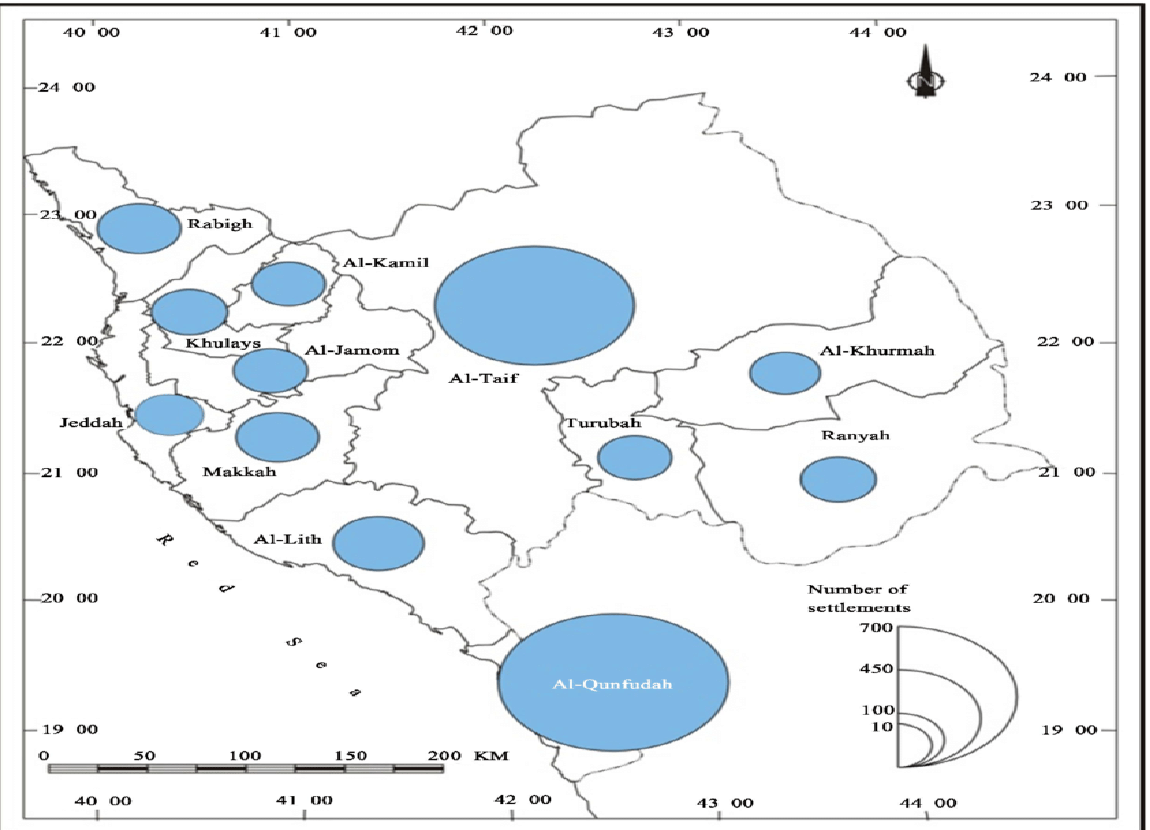
Figure 3. Holy Makkah al-Mukarramah municipalities [14].